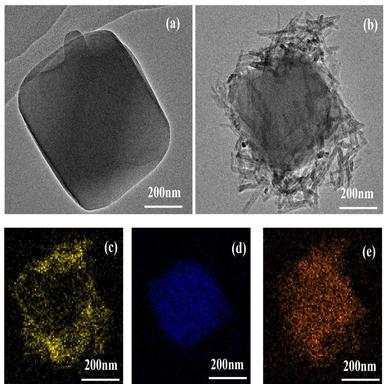
EM images of (a) UiO-66 and (b) Fe-UiO-66 and EDS Fe-UiO-66 (c) Fe (d) Zr and (e) O.